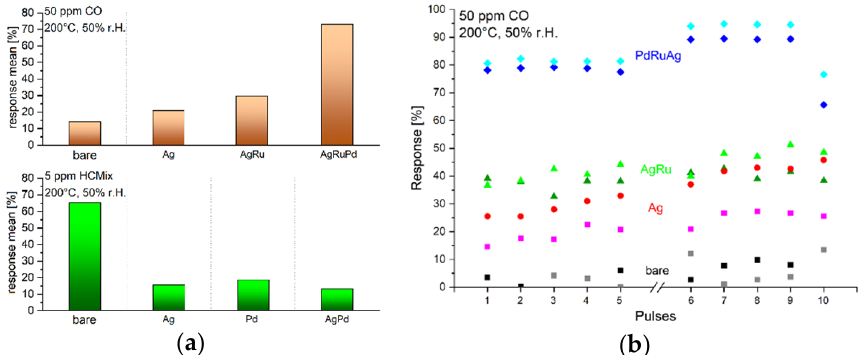
Figure 1. ( a ) Response of the bare SnO 2 -sensor and the sensors functionalized with Ag, AgRu, and AgRuPd nanoparticles (NPs) towards 50 ppm of CO and 5 ppm of HCMix in 50% rH, 200 °C; ( b ) stability test of the response—bare SnO 2 -sensor and SnO 2 +NPs sensors towards 50 ppm of CO in 50% rH, 200